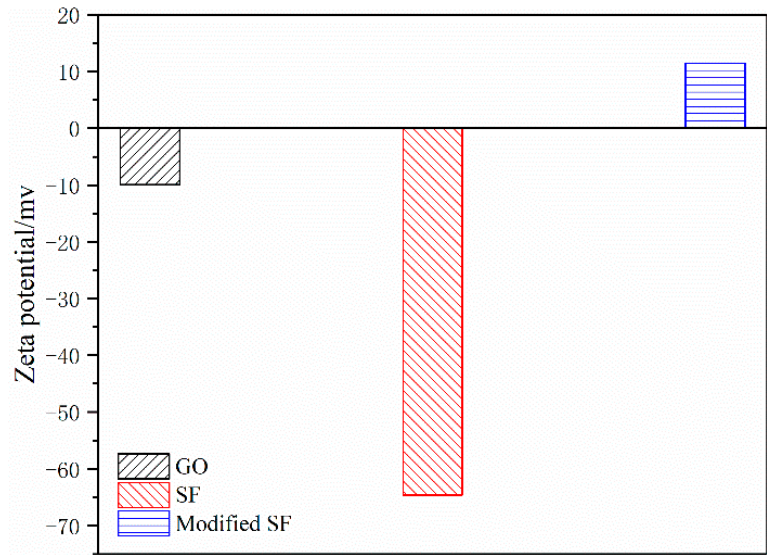
Figure 3. Zeta potential of GO, SF, and MSF.